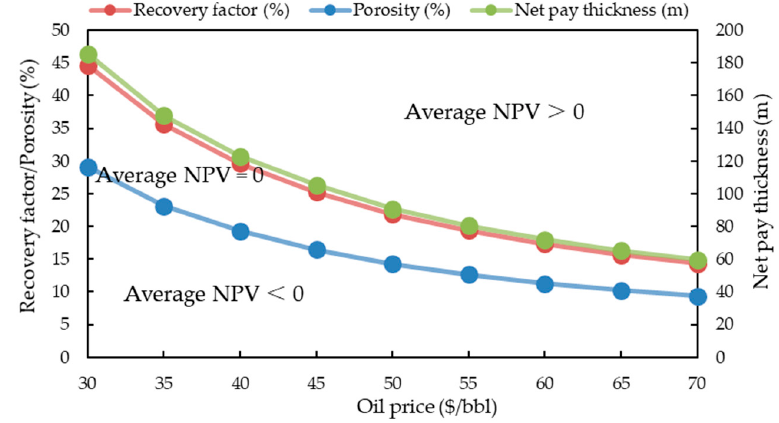
Figure 8. Key profit curves of reservoir parameters.